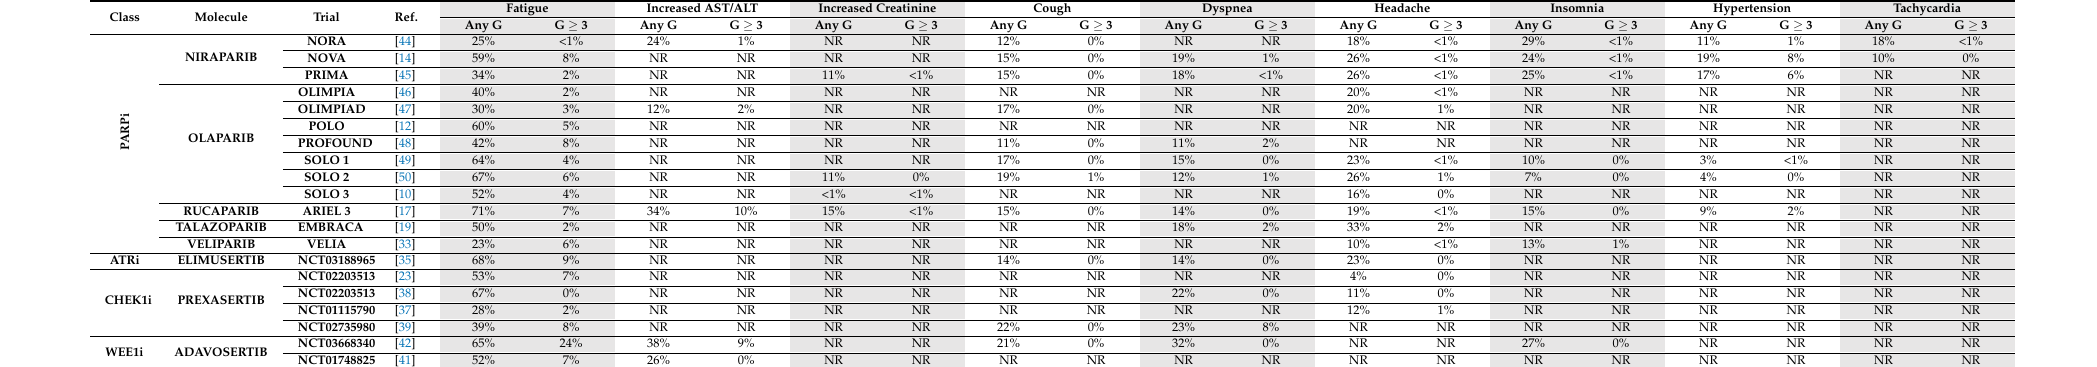
Table Legend: G: grade; NR: not